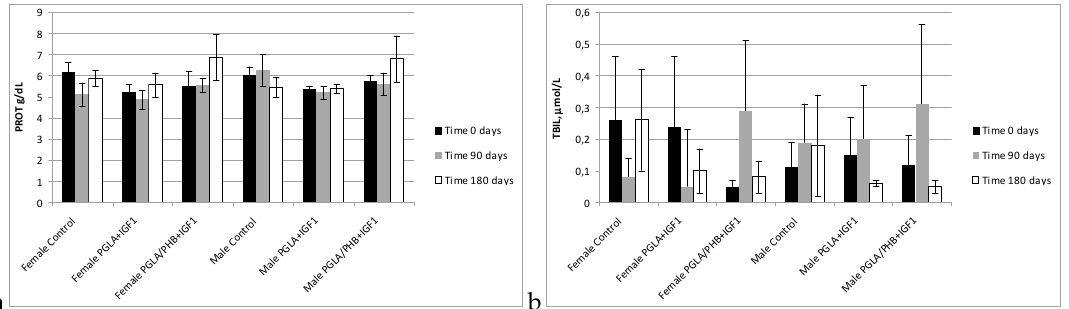
Figure 11. Protein (PROT) ( a ) and total bilirubin (TBIL) ( b ) concentration in blood of rabbits.